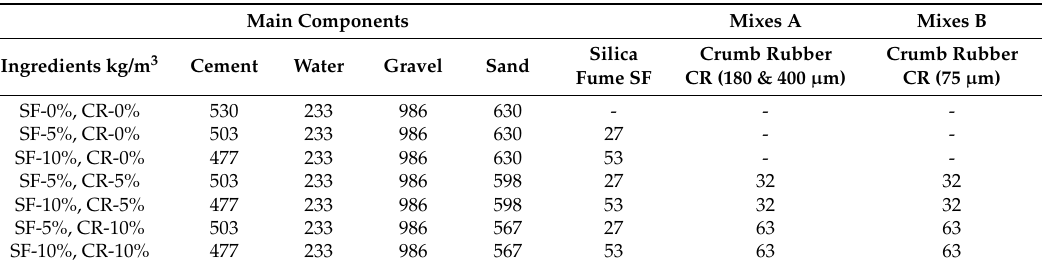
Table 3. Concrete mix